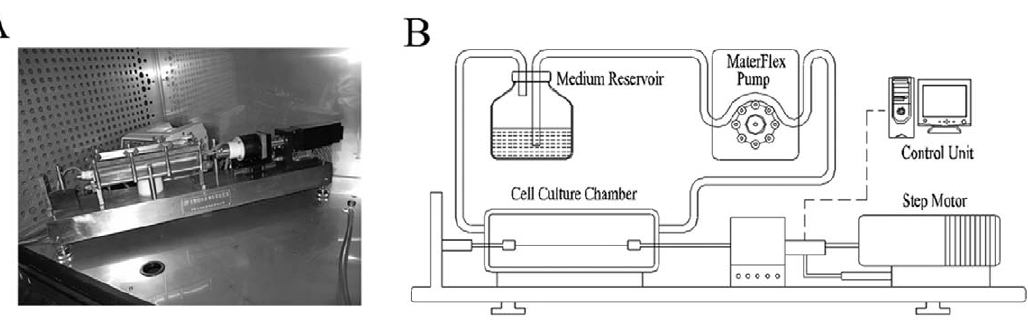
Figure 1. Stretch device. (A) Mechanical stretching device used in our laboratory. (B) Schematic representation of uniaxial stretch device.